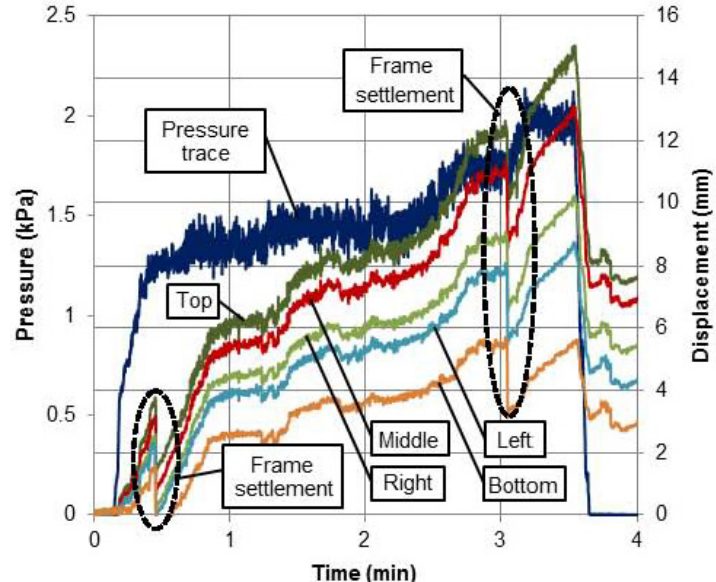
Figure 6. Test 2 displacement and pressure data. Sudden jumps in displacement occurred due to settlement of the instrumentation support